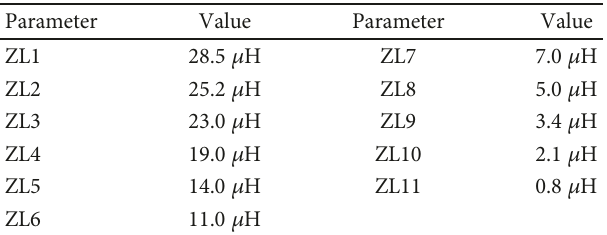
Table 2: The parameters of inductance loading in the LPDA. Parameter